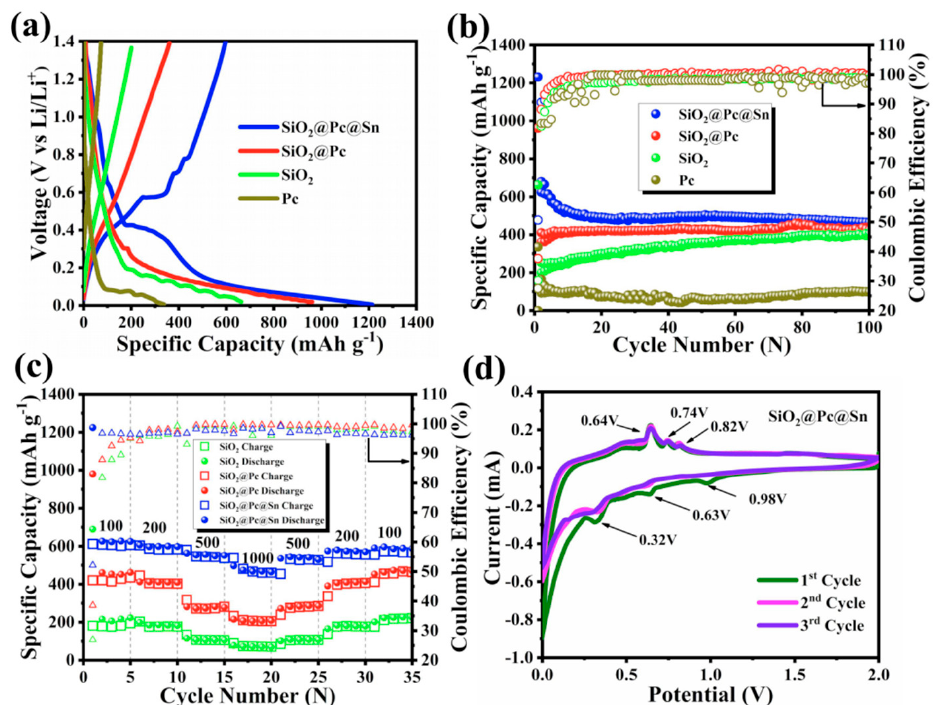
Figure 4. ( a ) Charge/discharge curve of different samples; ( b ) cycling performance curve of different samples; ( c ) the rate performance for different samples; ( d ) cyclic voltammetry (CV) curve of SiO 2 @Pc@Sn.